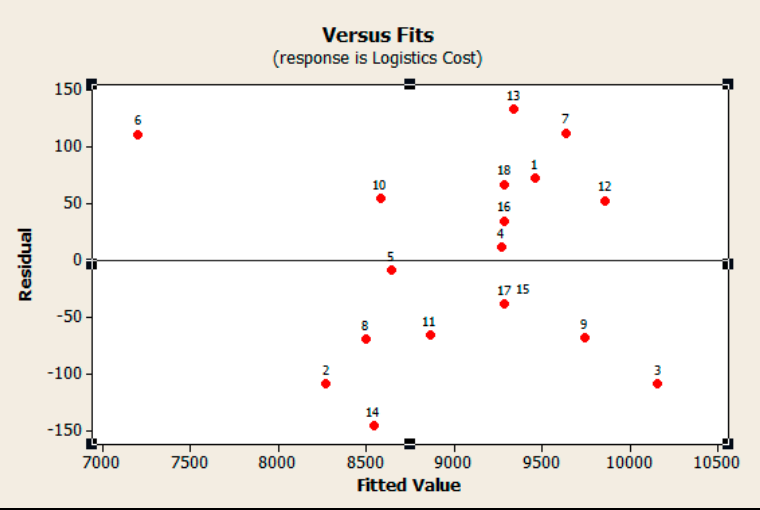
Figure 4. Residuals versus Fits Plot for Logistic Cost.